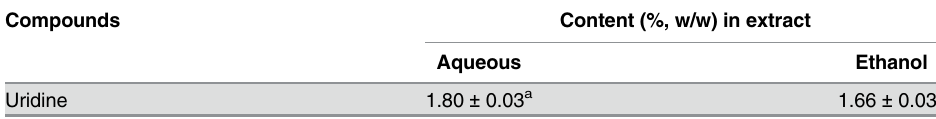
Table 1. Uridine (%, w/w) in the aqueous and ethanol extracts of P . giganteus . Compounds Content (%, w/w) in extract Aqueous Ethanol Uridine 1.80 ± 0.03 a 1.66 ± 0.03 b Note: (w/w) = g of compound per 100 g of mushroom extract. Different alphabets mean signi fi cant difference at p <